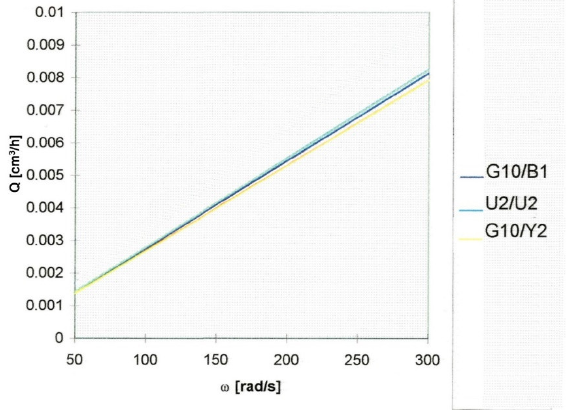
Figure 15. Variation of the leakage loss flow at an EFS103-S front seal as a function of the angular velocity and for different material couplings of the primary seal.